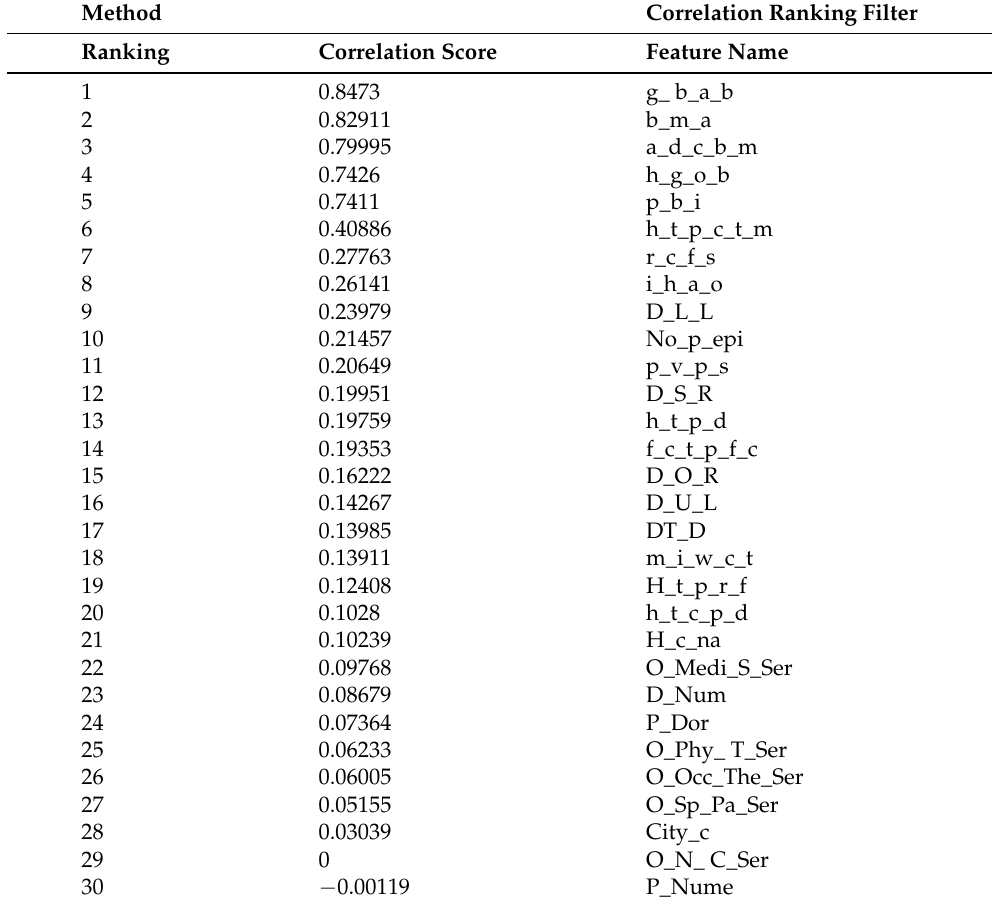
Table 2. Correlation score of each